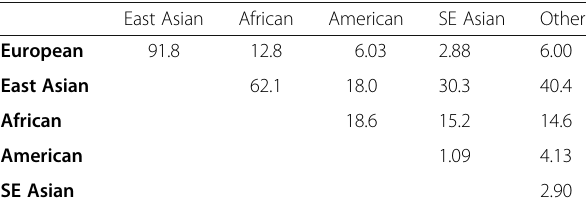
Table 3 Chi-square analysis of NEGR1 deletions in the general population